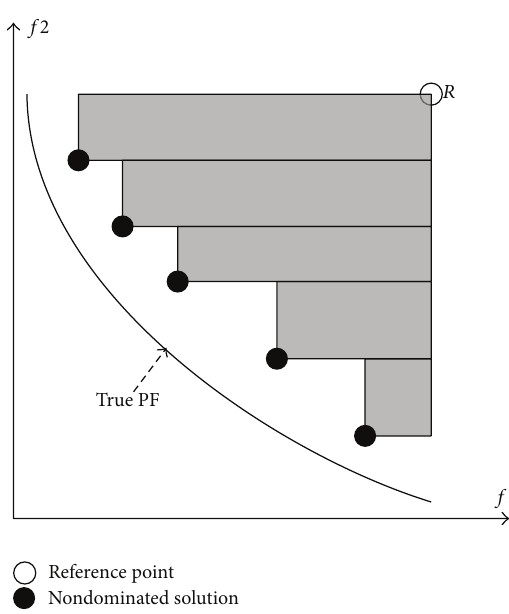
Figure 5: Hypervolume measure with area covered by nondominated solutions and reference point.